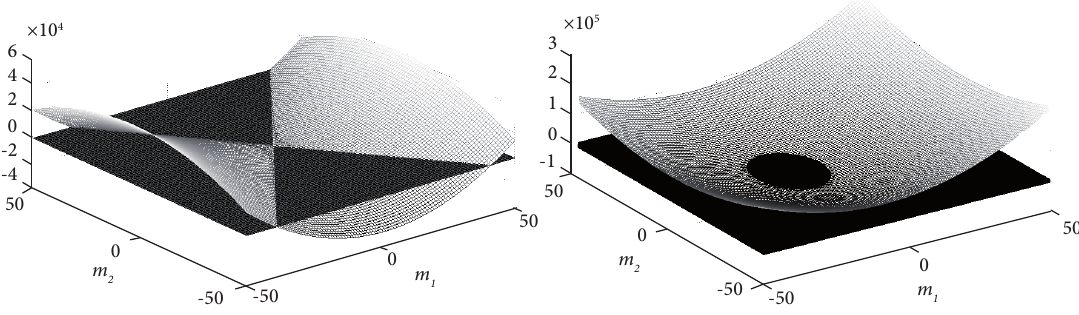
Figure 1. Intersection of the Z=Z plane with the SDS to illustrate the different forms of the decision boundary. o SDS = sufficient decision